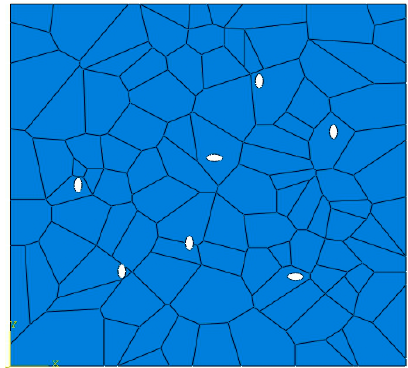
Figure 7. The distribution of pores on the polycrystalline model components.